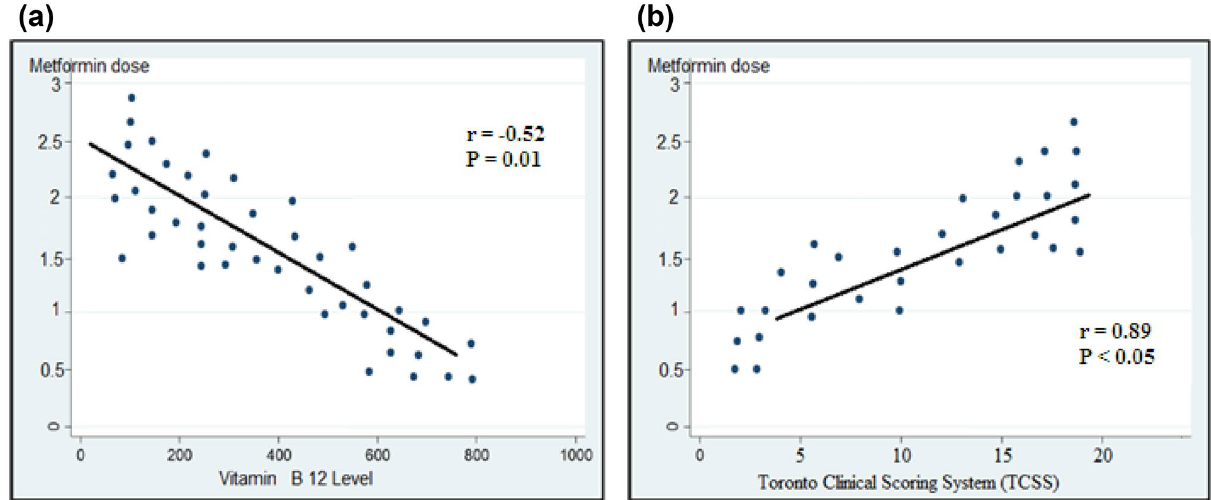
Figure 1. ( A ) Correlation of vitamin B12 and metformin dose. ( B ) Correlation of Toronto Clinical Scoring System and metformin